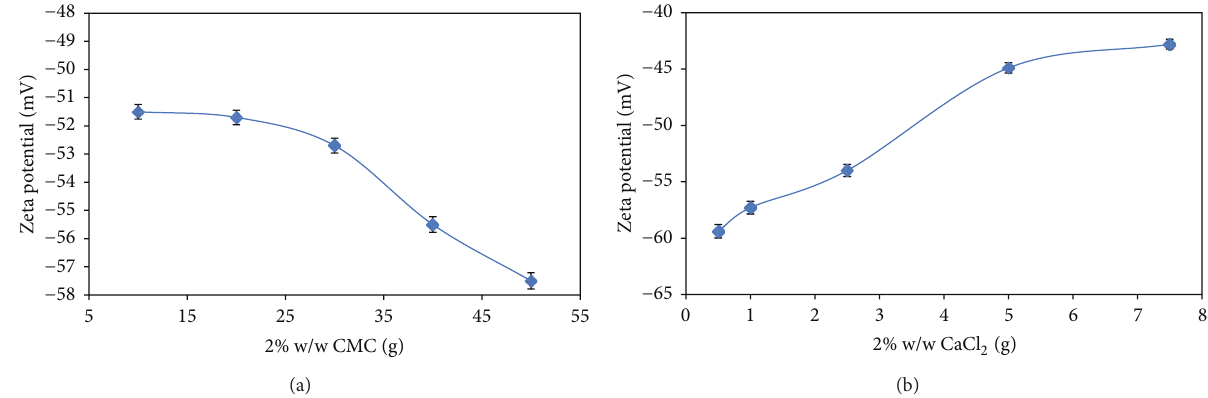
Figure 8: Effect of (a) CMC (g) and (b) CaCl 2 on the zeta potential of nanocapsules of SA/CMC blend crosslinked with Ca 2+ .